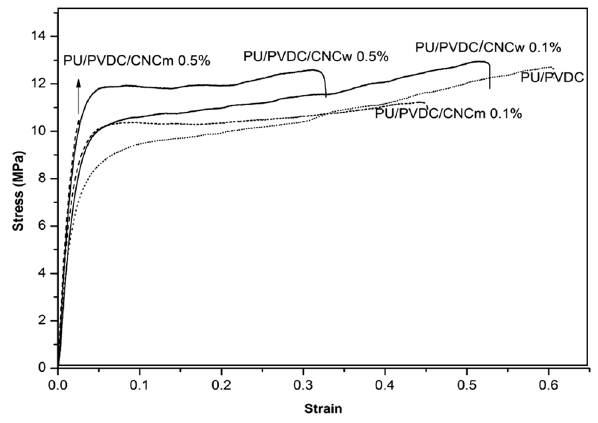
Fig. 6 Stress–strain curves of PU/PVDC composite films containing different types of